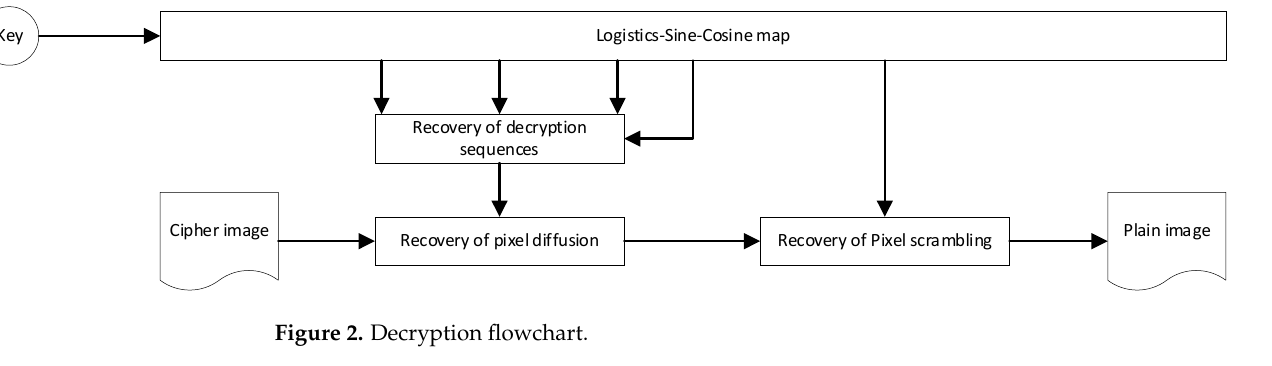
Figure 2. Decryption flowchart.